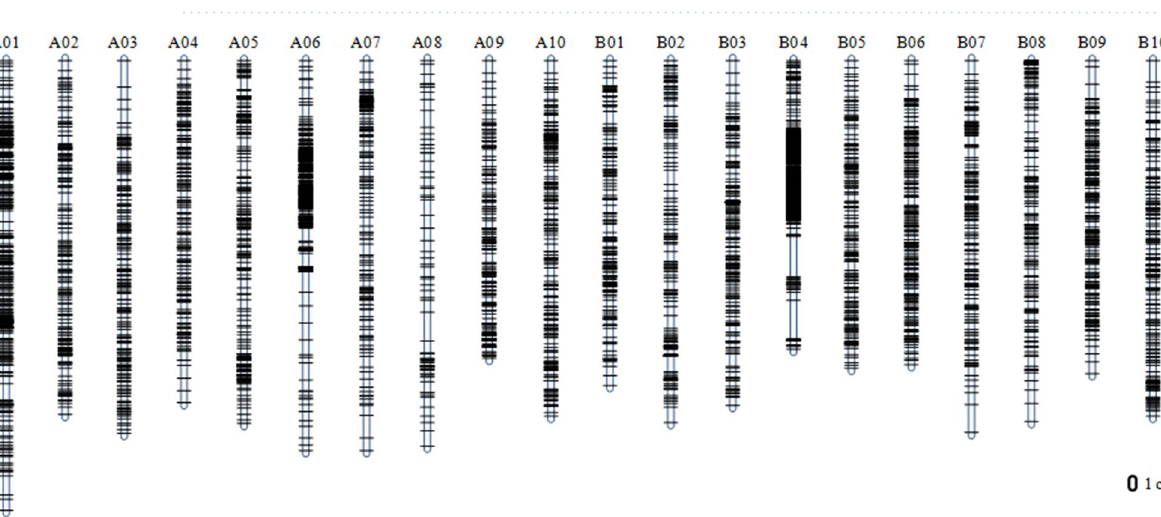
Figure 2. SLAF-markers selection and the construction of genetic linkage maps of RIL (F 6 ) population. ( a ) The integrity of individuals in F 6 population; ( b ) genotype distribution of SLAF markers; ( c ) polymorphic SLAF markers distribution on the physical map of peanut; ( d ) co-linearity of genetic linkage map and physical map of RIL (F 6 ) population.